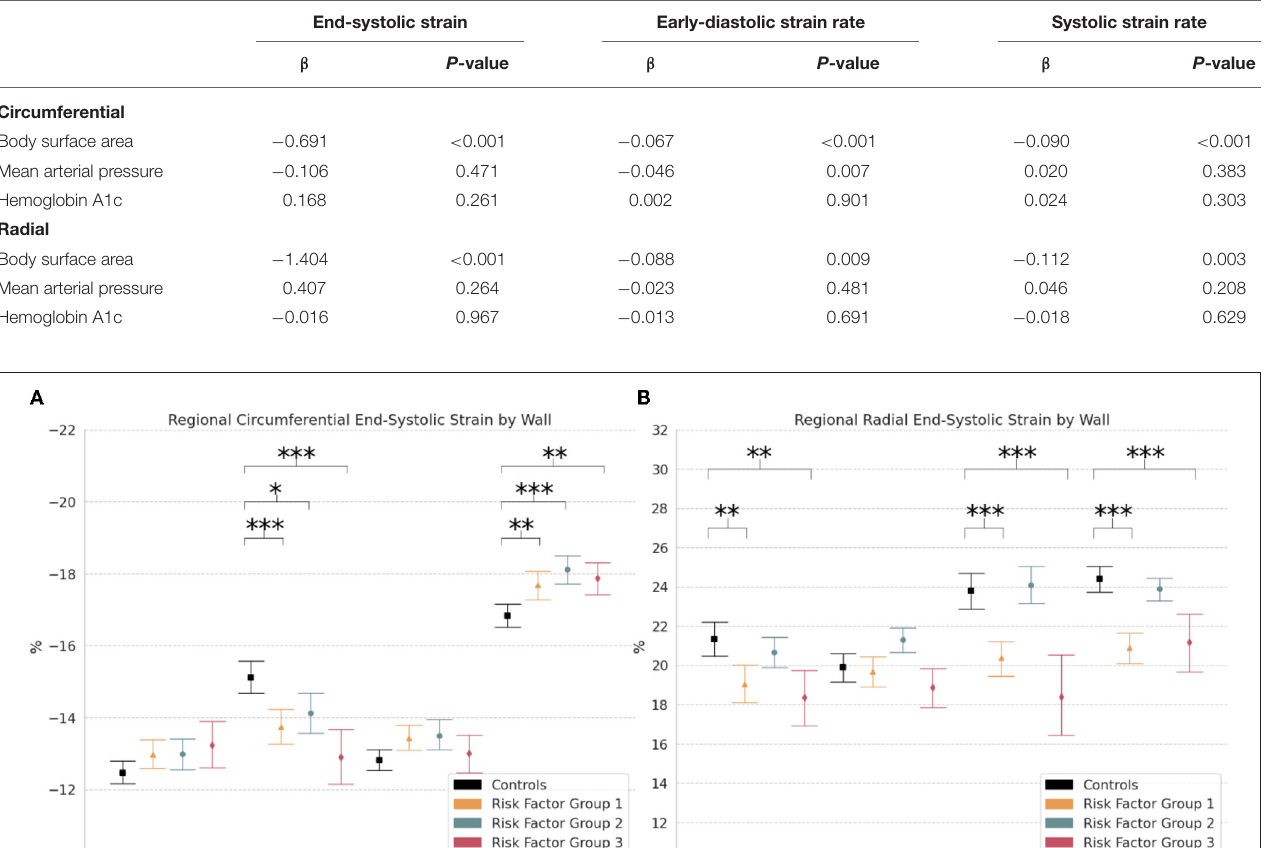
TABLE 3 | Independent correlates of global strain measures.